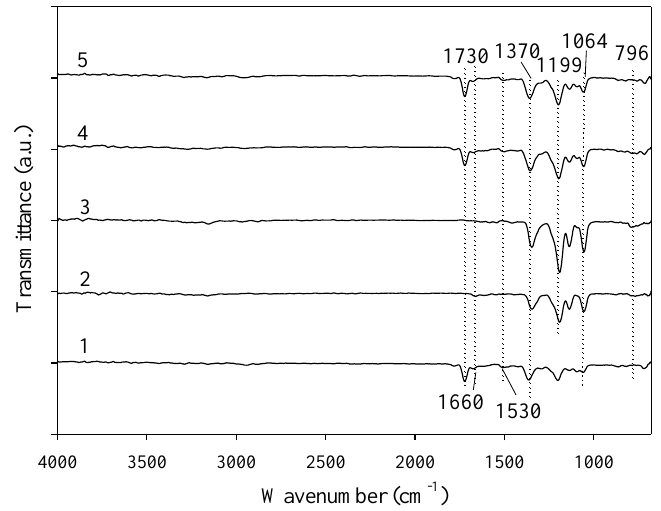
Figure 6. Cross-section SEM images of cryo-fractured membranes: ( a ) Matrimid ® film, ( b )